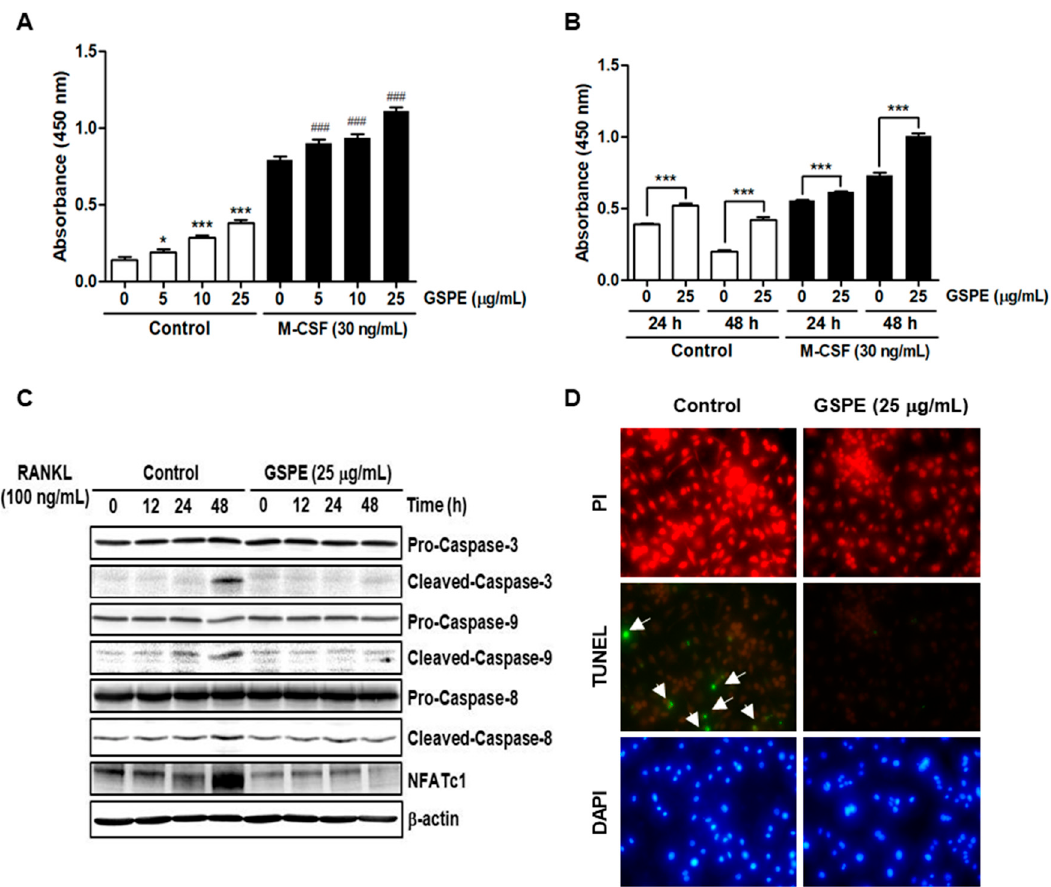
Figure 6. GSPE promotes proliferation and inhibits apoptosis. ( A ) BMMs were cultured for 48 h with the indicated doses of GSPE in the presence or absence of 30 ng / mL M-CSF. * p < 0.05; *** p < 0.001 versus 0 g / mL in control, ### p < 0.001 versus each dose in control. ( B ) BMMs were cultured in the presence or absence of 25 µ g / mL GSPE and 30 ng / mL M-CSF for the indicated time periods. Cell viability was determined using XTT assay. *** p < 0.001. ( C ) BMMs were stimulated using 100 ng / mL RANKL in the presence or absence of 25 µ g / mL GSPE with 30 ng / mL M-CSF for the indicated time periods. The protein expression levels of caspase-3, -8, and -9 were evaluated using Western blot analysis. ( D ) BMMs were cultured with 30 ng / mL M-CSF and 100 ng / mL RANKL in the presence or absence of 25 µ g / mL GSPE. The cells were fixed, permeabilized, and stained with TUNEL, PI, and DAPI and then examined under a fluorescence microscope. Abbreviations: GSPE, grape seed proanthocyanidin extract; RANKL, receptor activator of nuclear factor kappa-B ligand; M-CSF, macrophage colony-stimulating factor; TUNEL, Terminal deoxynucleotidyl transferase dUTP nick end labeling; PI, propidium iodide; DAPI, 4 ′ ,6-Diamidino-2-phenylindole dihydrochloride.